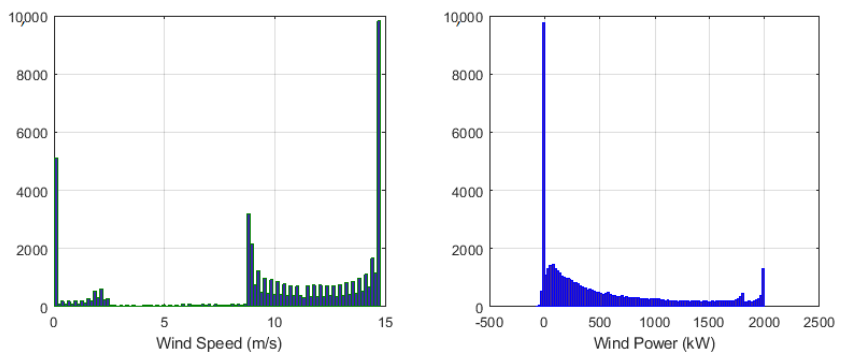
Figure 4. The distribution of the raw SCADA data WT1 (wind speed and power).